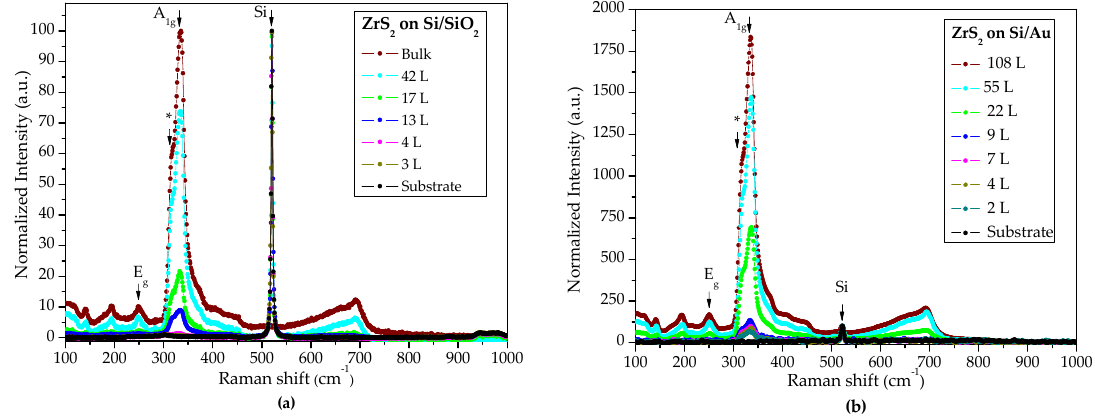
Figure C1. Thickness dependence of the Raman spectra for ZrS 2 ( λ = 532 nm) ( a ) on a silicon substrate with 285 nm of SiO 2 and ( b ) on a silicon substrate covered with Ta (3 nm)/Au (30 nm). The Raman modes A 1g and E g are labeled. The shoulder marked with “*” is attributed to a broadening of the A 1g peak due to non ‐ harmonic effects.